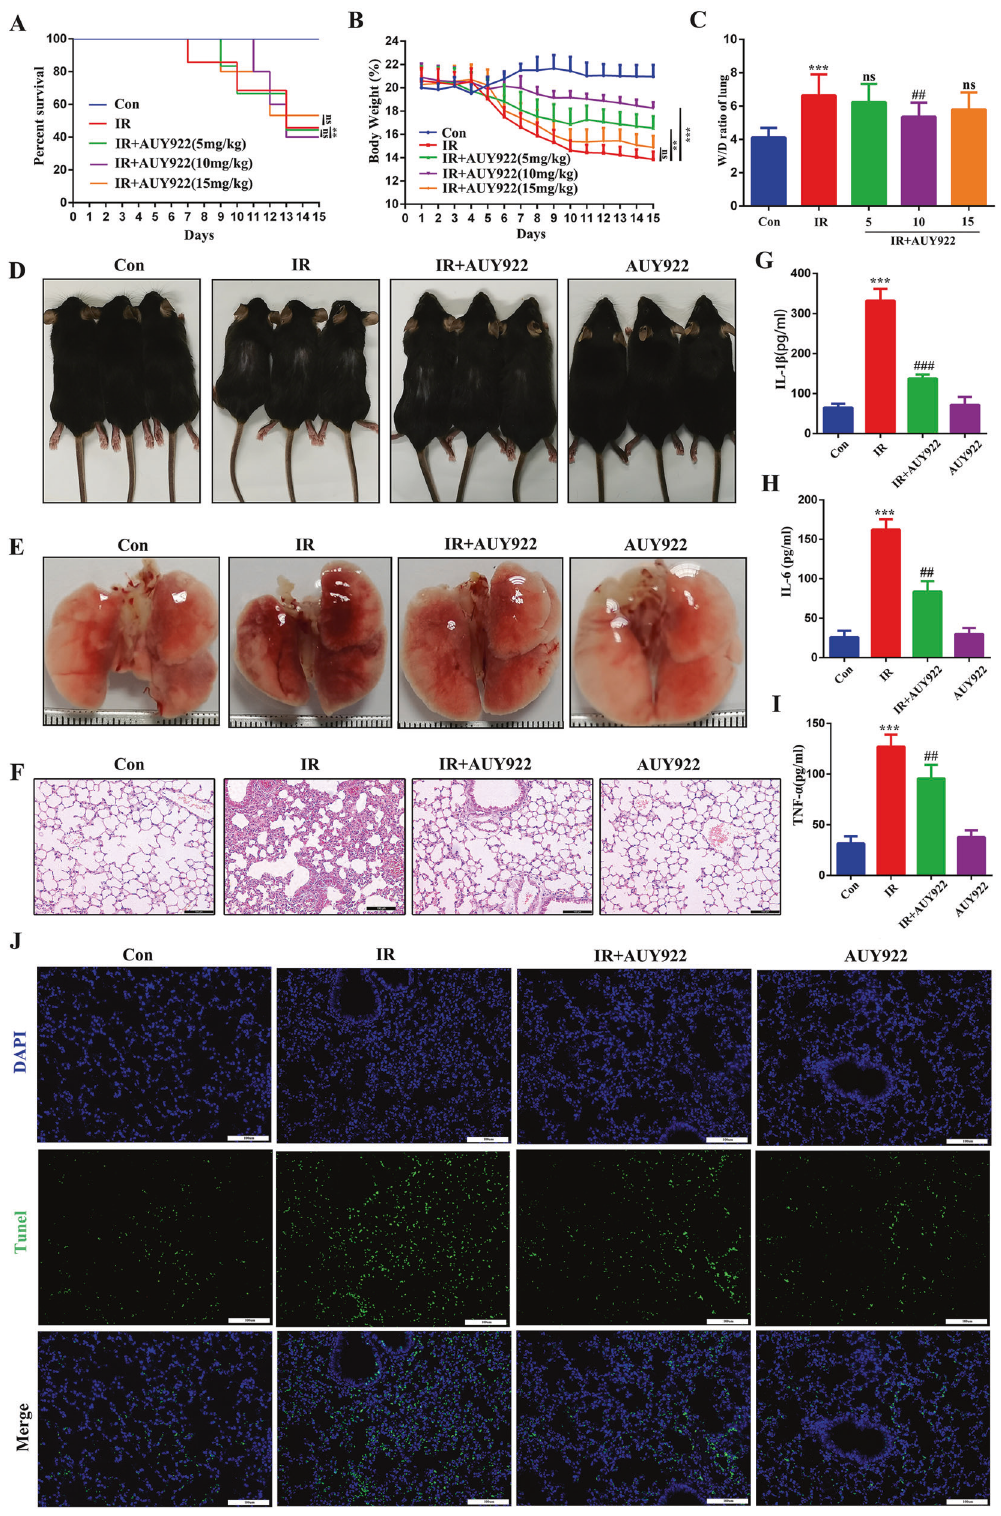
Fig. 2 NVP-AUY922 improved survival and lung injury induced by IR in mice. A Survival curves. B Body Weight. C W/D ratio of the lungs. D Depilation of mice after radiation. E Representative images of lung tissues. F Representative HE staining images of the lung tissues. G – I Concentrations of IL-1 β ( G ), IL-6 ( H ), and TNF- α ( I ) in serum. J TUNEL staining of lung sections. Mice ( n = 12) were pre-treated with NVP-AUY922 (5 mg/kg, 10 mg/kg, 15 mg/kg, i.p.) or vehicle (i.p.) 2 h prior to a single radiation dose of 10 Gy (dose rate of 2.0 Gy/min), then continuously administered from day 2 to day 5. Animals were sacri fi ced on day 16. #/ * P < 0.05, ##/ ** P < 0.01, ###/ *** P < 0.001, # vs. IR group; * vs. control group.